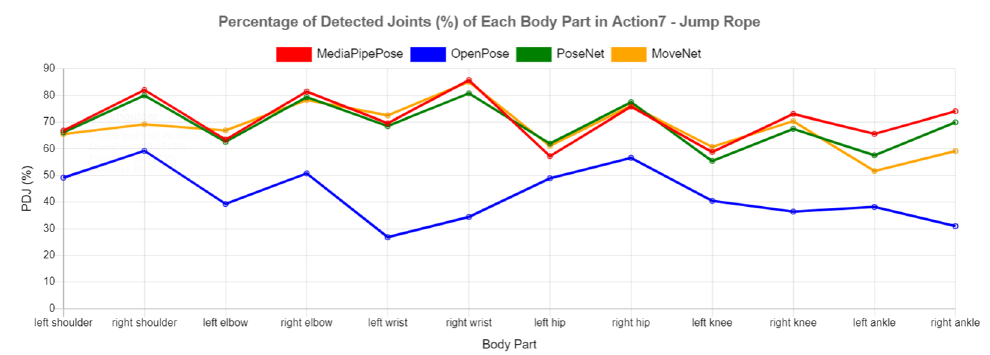
Figure 16. PDJ for each body part in Action 7 (jump rope).